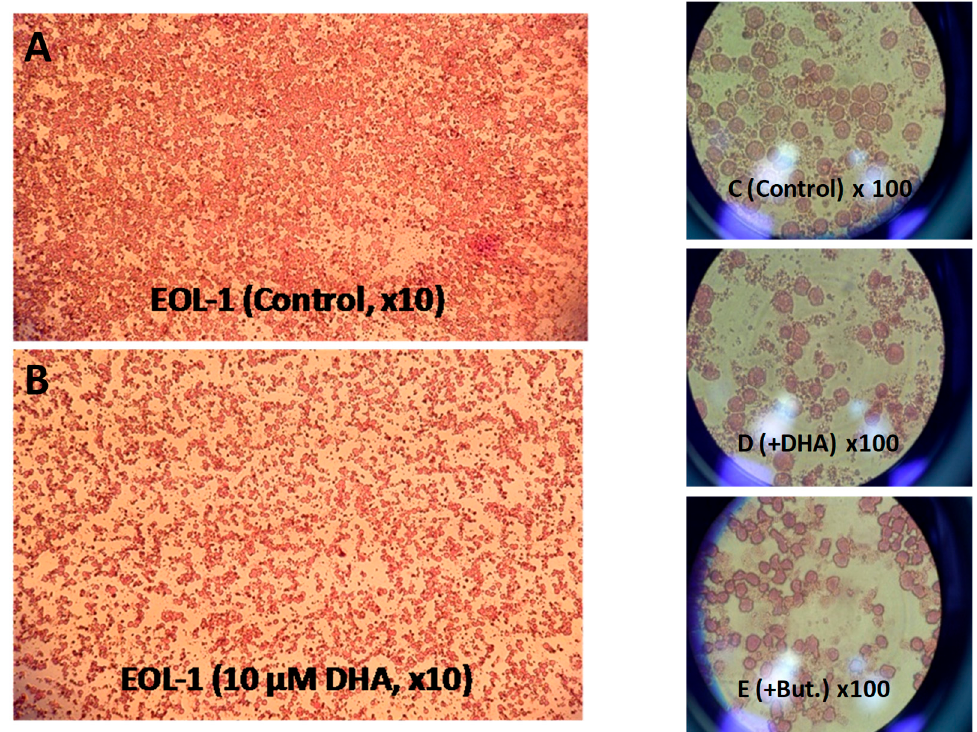
Figure 3. Light microscopy of EoL-1 cell culture. ( A ) in the absence of DHA (Control EoL-1 cell culture with ethanol in the medium) and ( B ) in the presence of 10 µ M DHA, after 3 days of incubation at 37 ◦ C/5% CO 2 . ( C ) Effect of DHA on morphology of EoL-1 cells: control EoL-1 cells × 100 magnification. ( D ) 10 µ M DHA treated EoL-1 cells × 100 magnification. ( E ) 500 µ M Butyrate treated EoL-1 cells × 100 magnification.